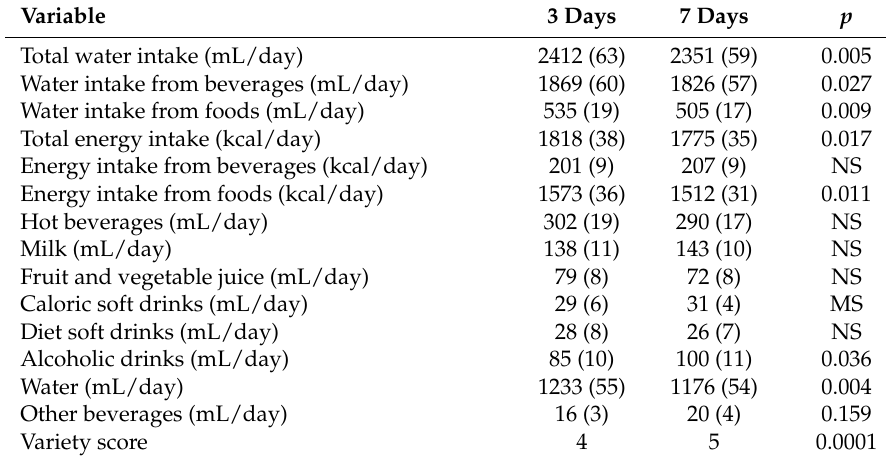
Table 7. Water and energy intake of subjects the first three days and the seven days of the experiment using day diaries ( n =